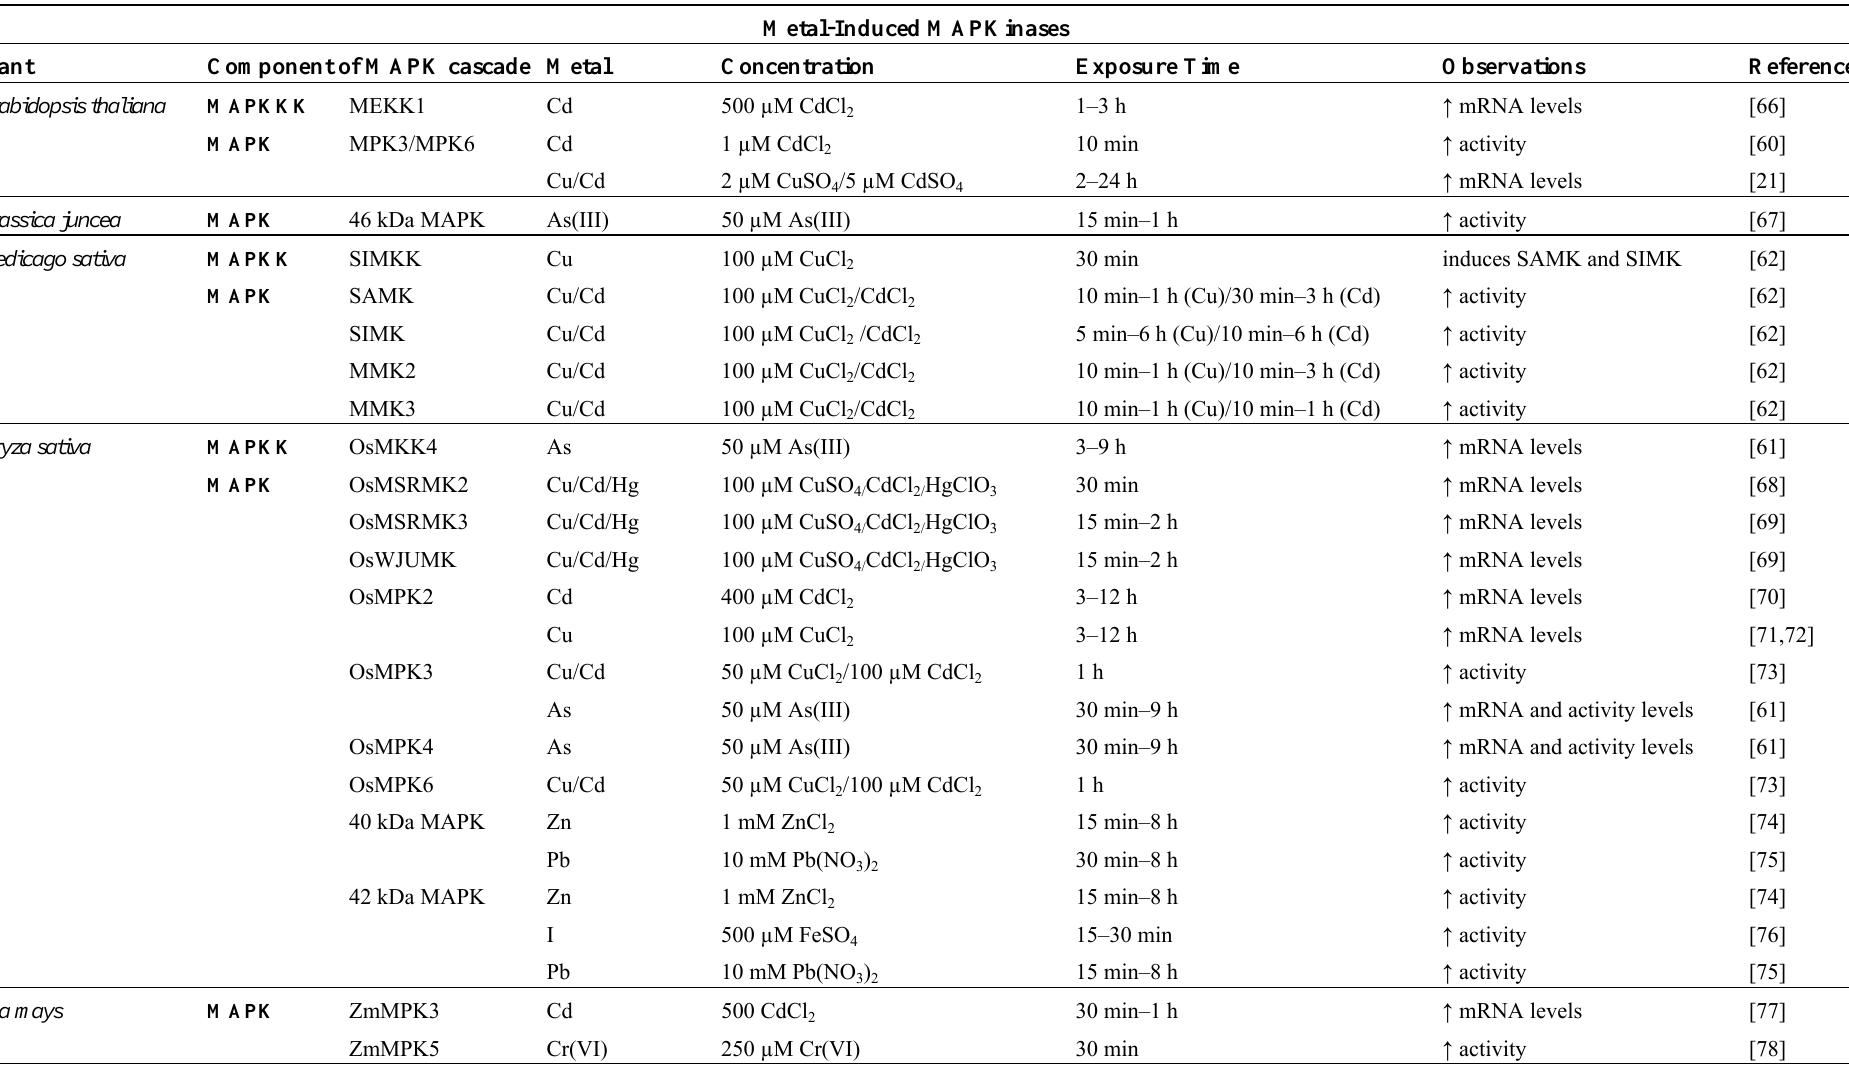
Table 2. Induction of MAPKinases under metal stress. MAPK cascade modules affected by exposure to metals are categorized based upon plant species and type of kinase. Exposure to metals influences MAPKinase mRNA levels as well as the activity at the protein